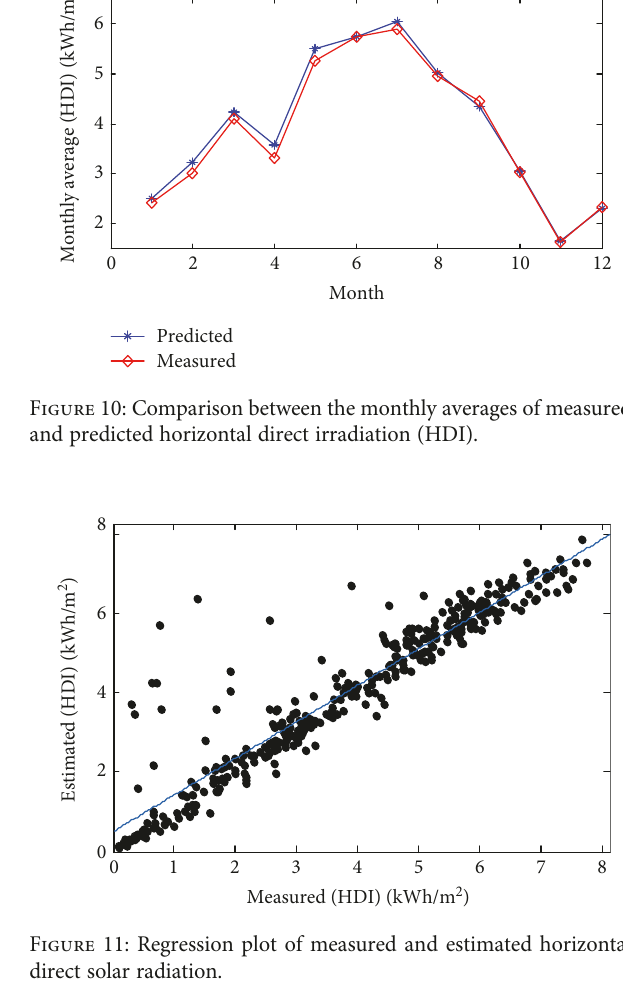
Table 5: Best performance of FFNN architectures.